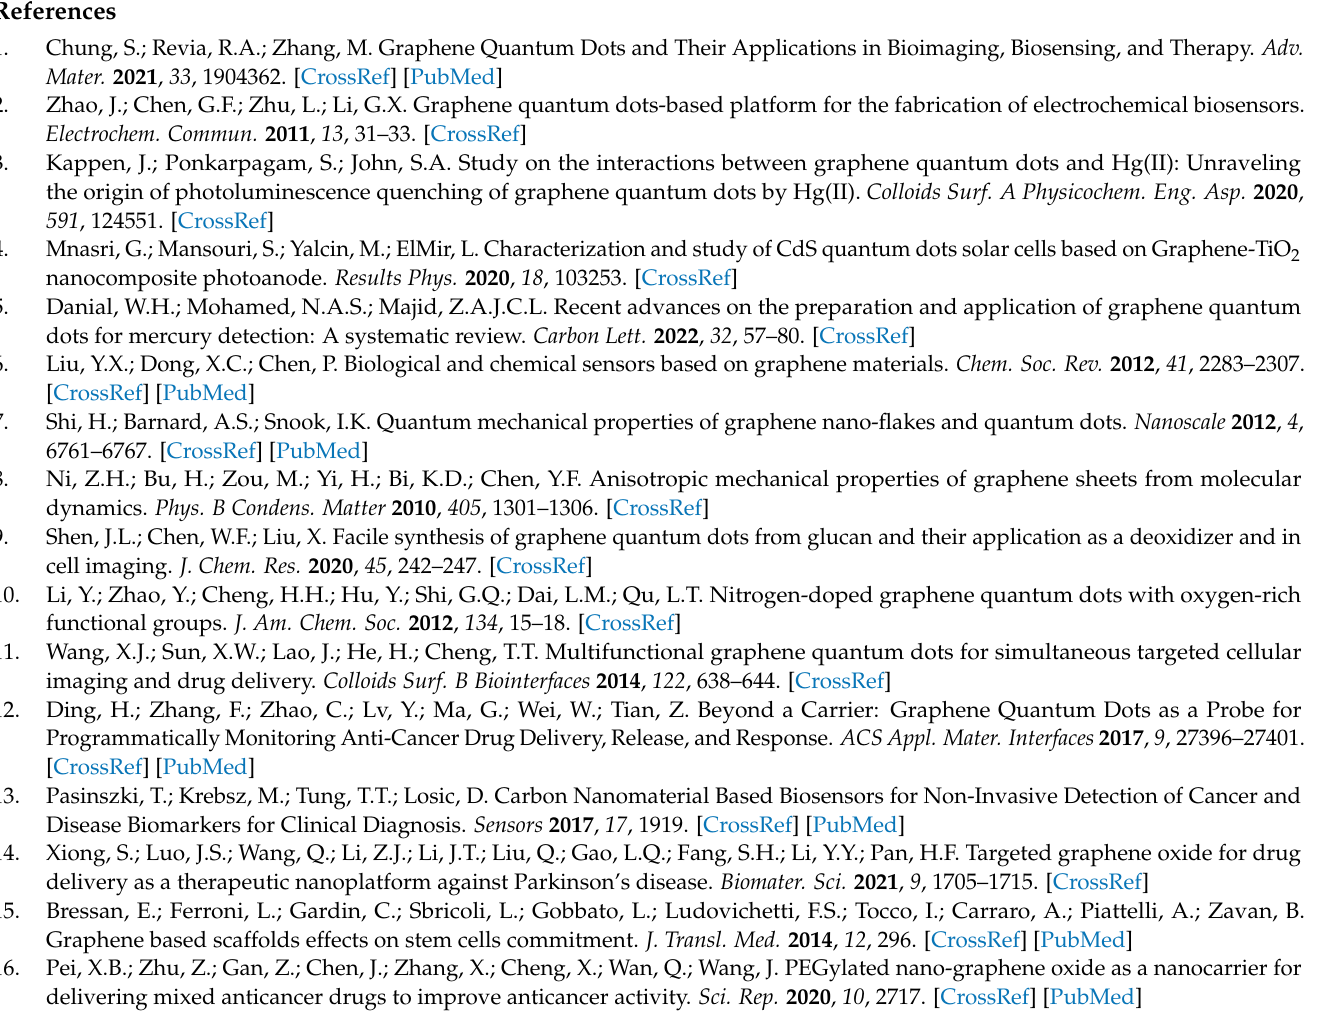
Figure S2: The average force (PMF) potential of GQDs transport through the membrane. The green dotted line indicates the two boundaries of the cell membrane. Table S1: Details of simulation calculations, Table S2: The LJ and charge parameters used in the MD. References [47–52] are cited in the supplementary